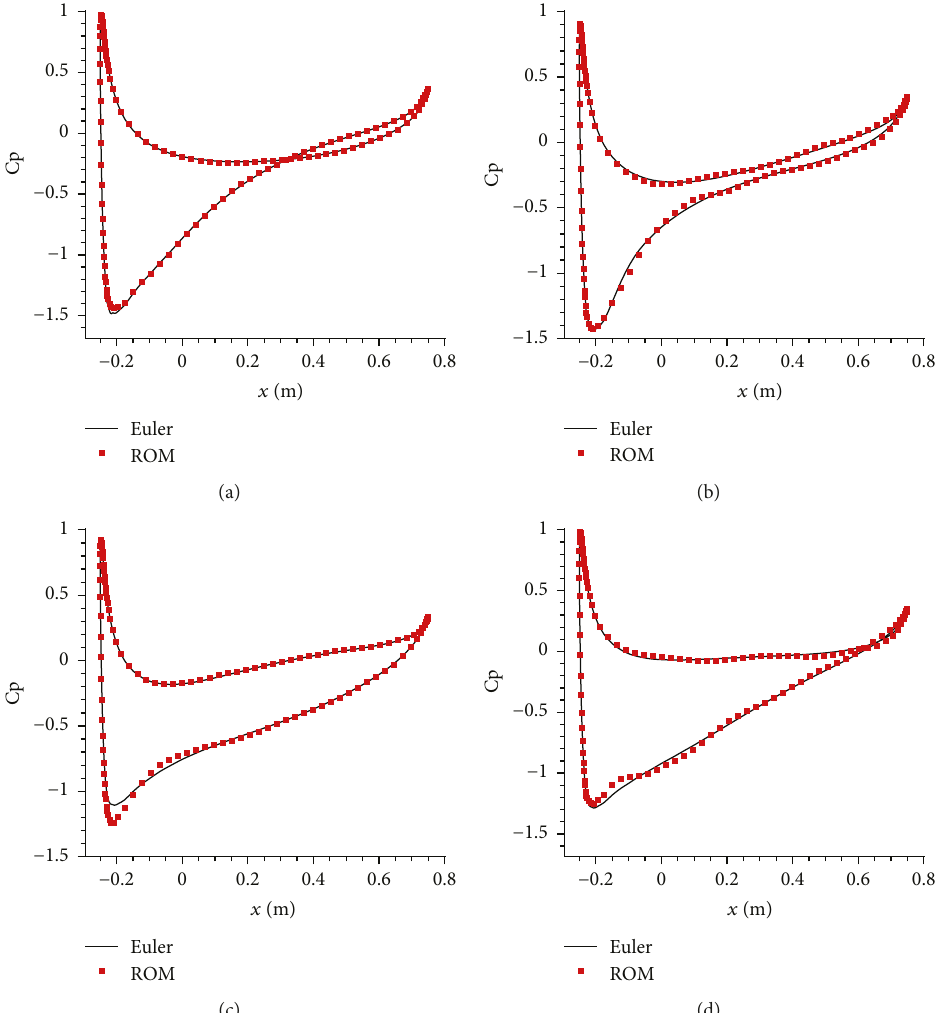
Figure 10: Pressure distribution predicted by the Euler and ROM at (a) T/4, (b) 2T/4, (c) 3T/4, and (d) T when f = 90 Hz.